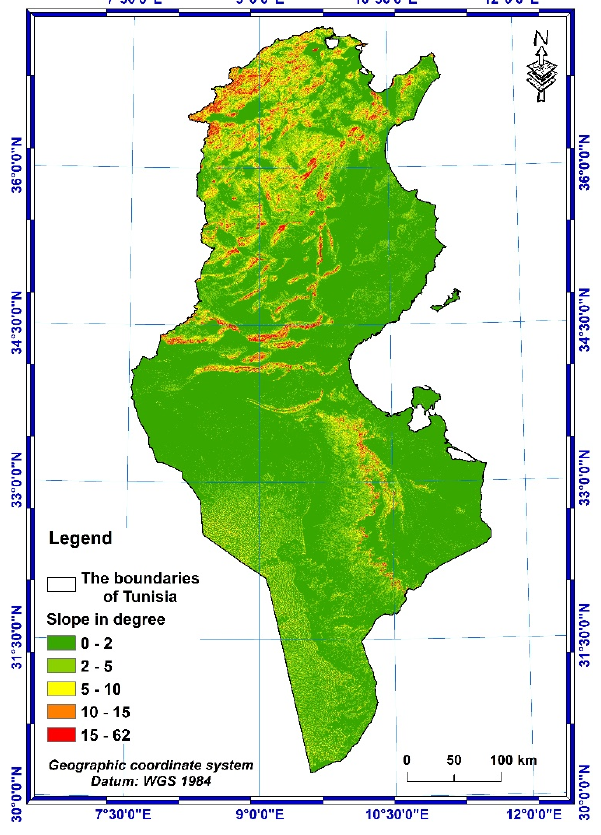
Figure 5. Slope map of Tunisia.